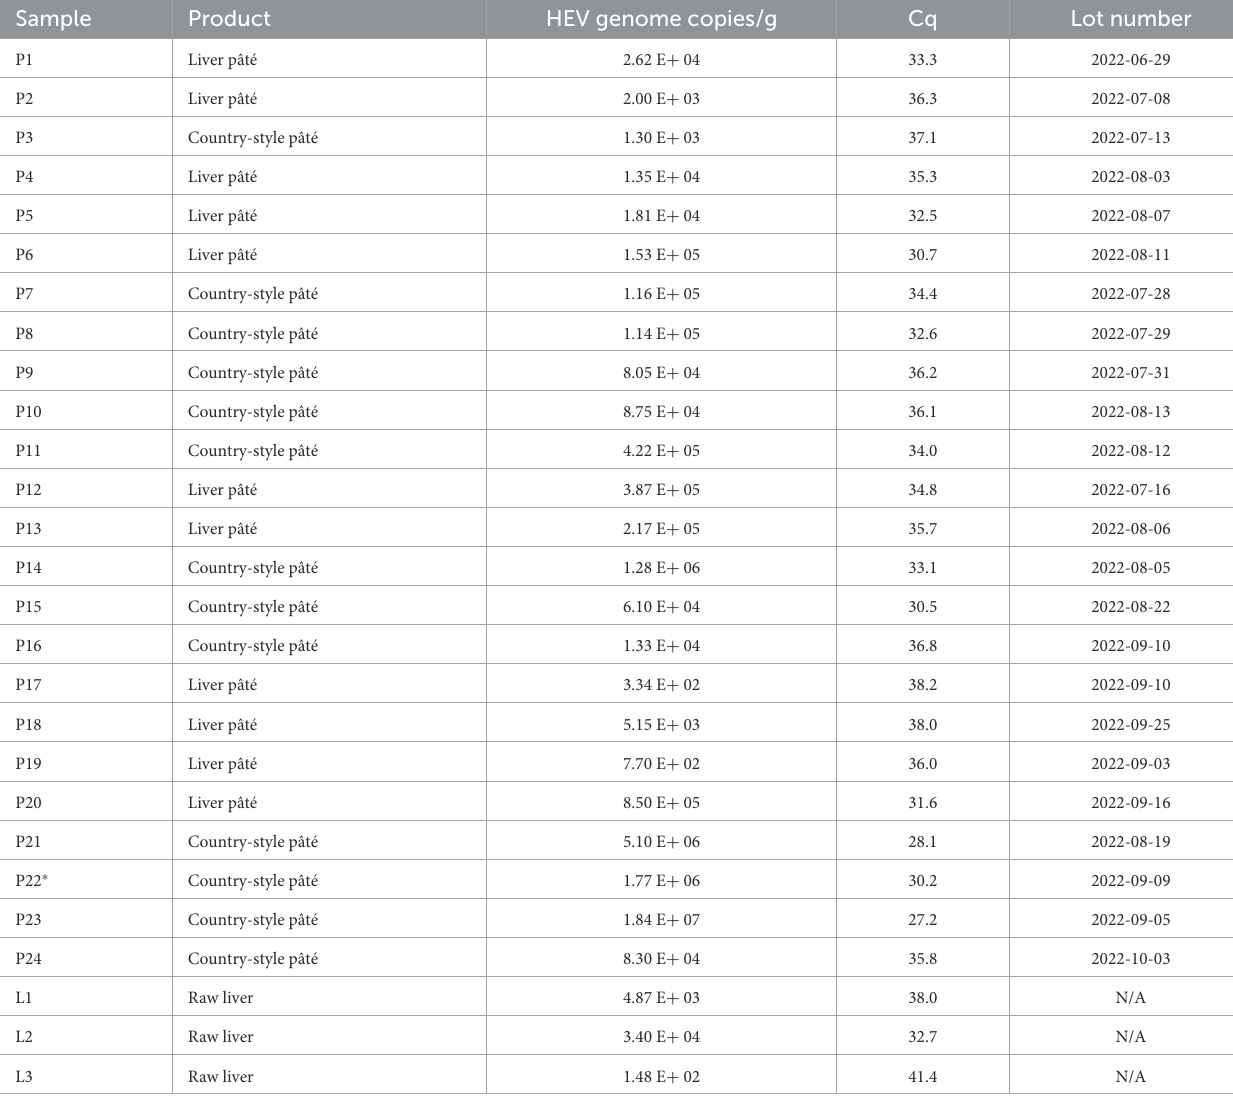
TABLE 3 HEV RNA detection in samples of pork liver pâté, country-style pâté, or raw liver.